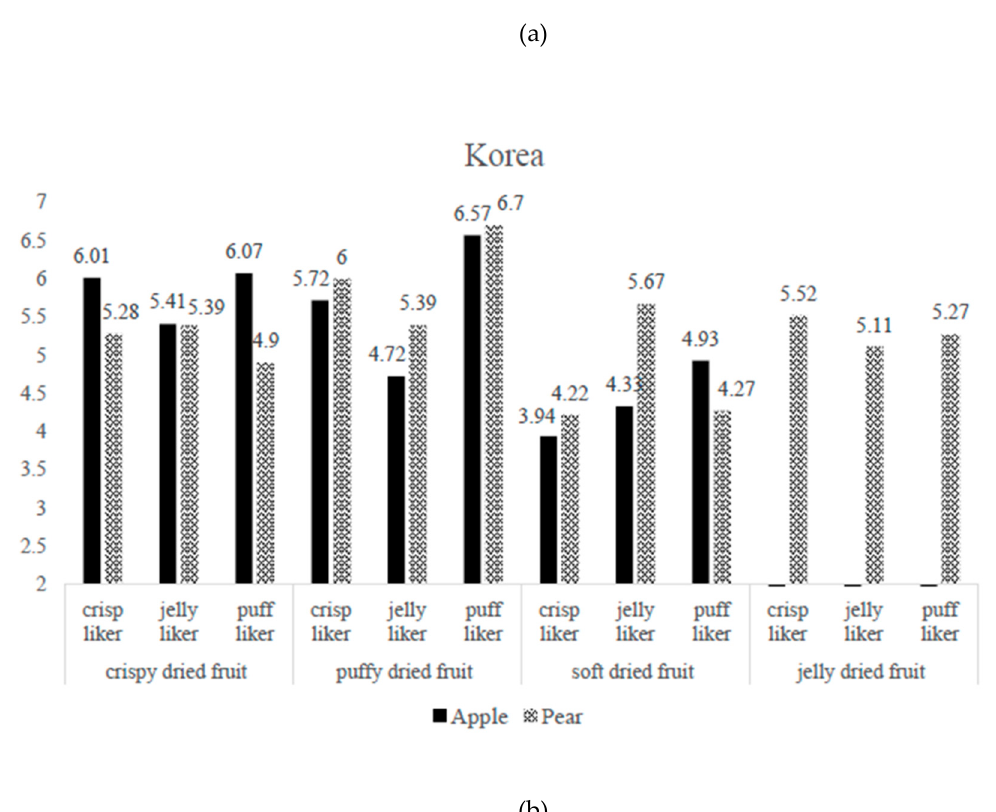
Figure 5. Effects of interaction between snack texture preferences and dried fruit-chip texture on the texture liking of dried apple and pear among Chinese ( a ) and Korean ( b ).